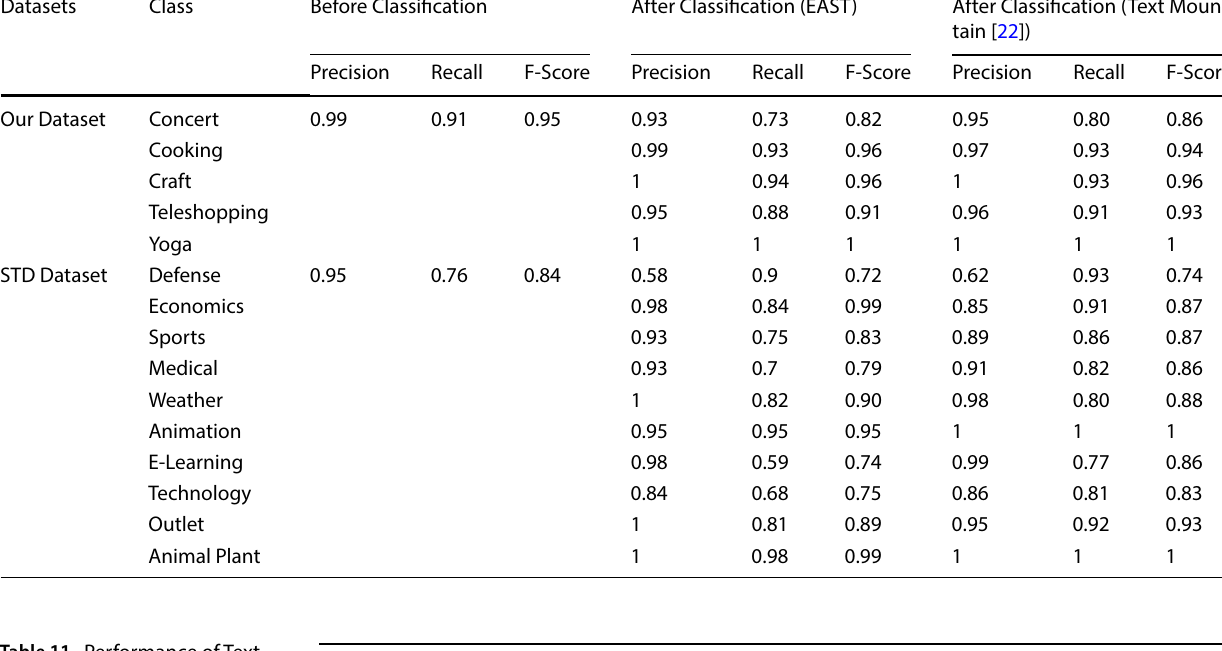
Table 11 Performance of Text Recognition methods E2E-MLT [24] and STAN[29] on our and STD datasets before and after